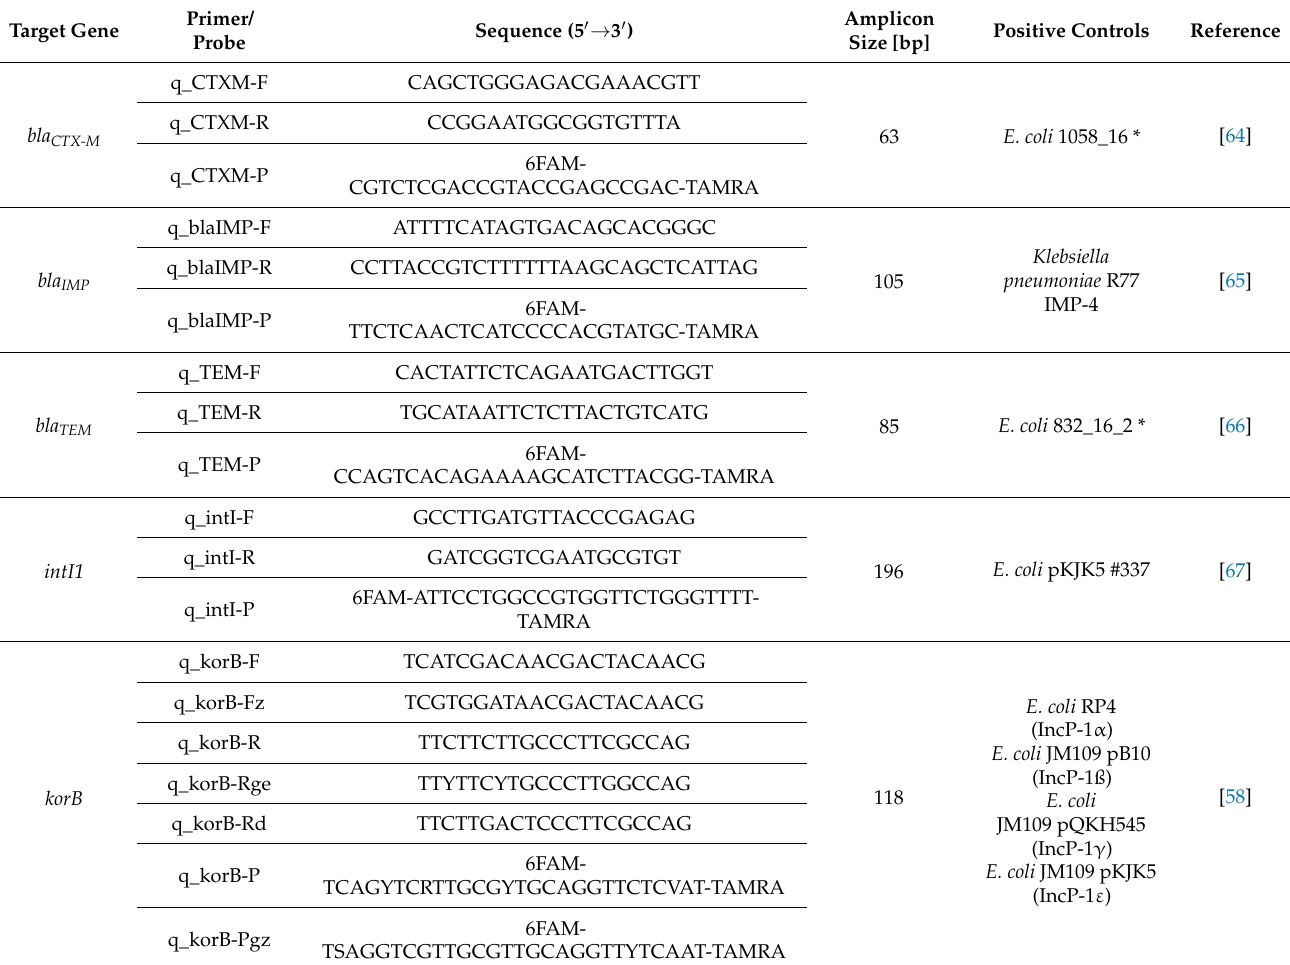
Table 1. qPCR primers and probes with target gene, oligonucleotide primer sequence, amplicon size, positive control for generation of standards, and primer/probe reference. Standard curves of 10 1 to 10 8 gene copies were used for